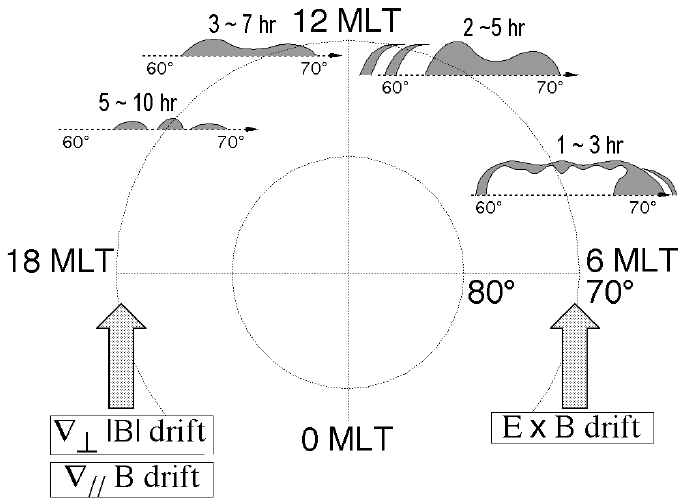
Fig. 7. A summary illustration of MLT dependence of the wedge-like structure for both the morphology and typical time-lags from the substorm activity.